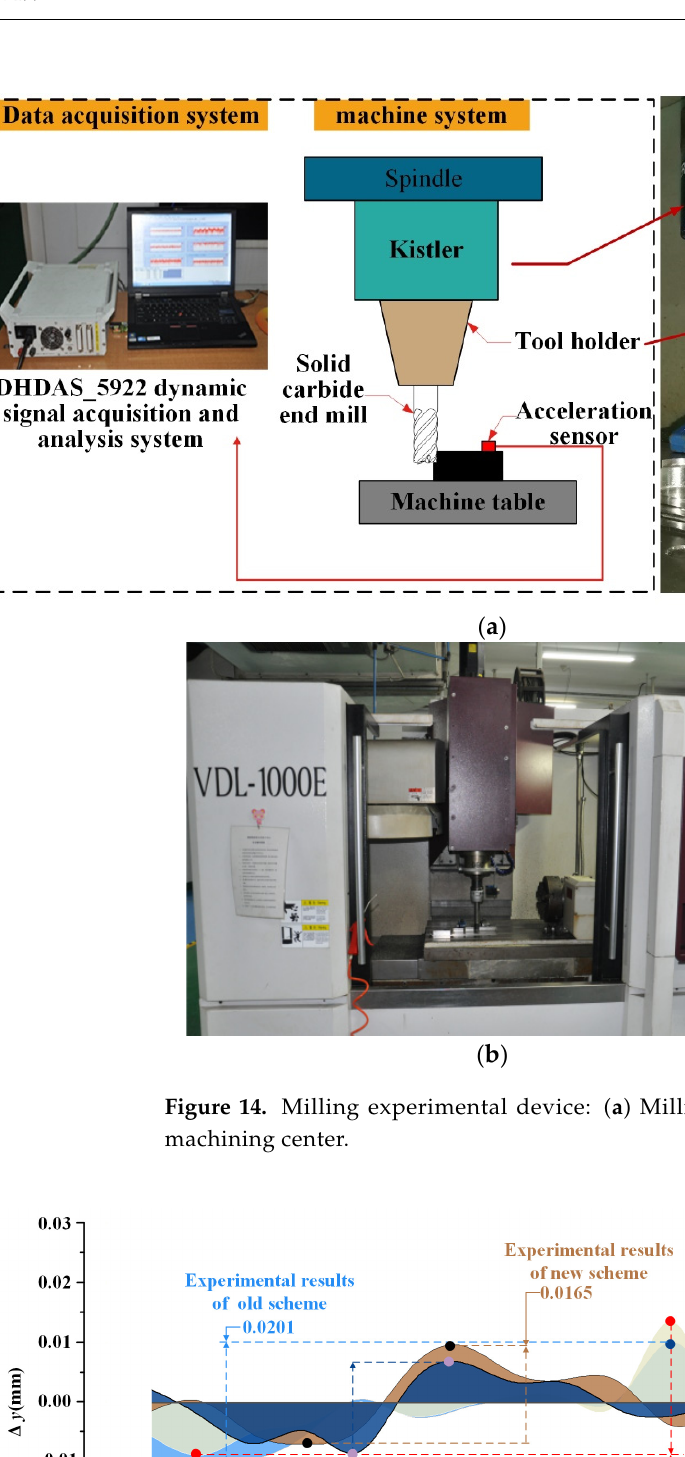
Table 6. The material composition of the TC4 titanium alloy workpiece.